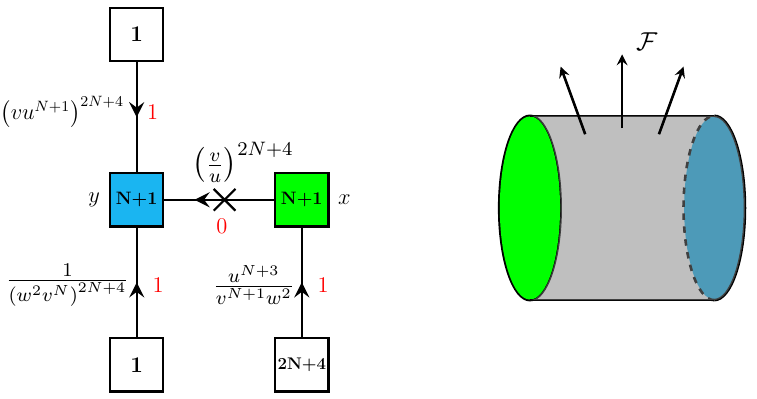
Figure 14: Quiver description of the A